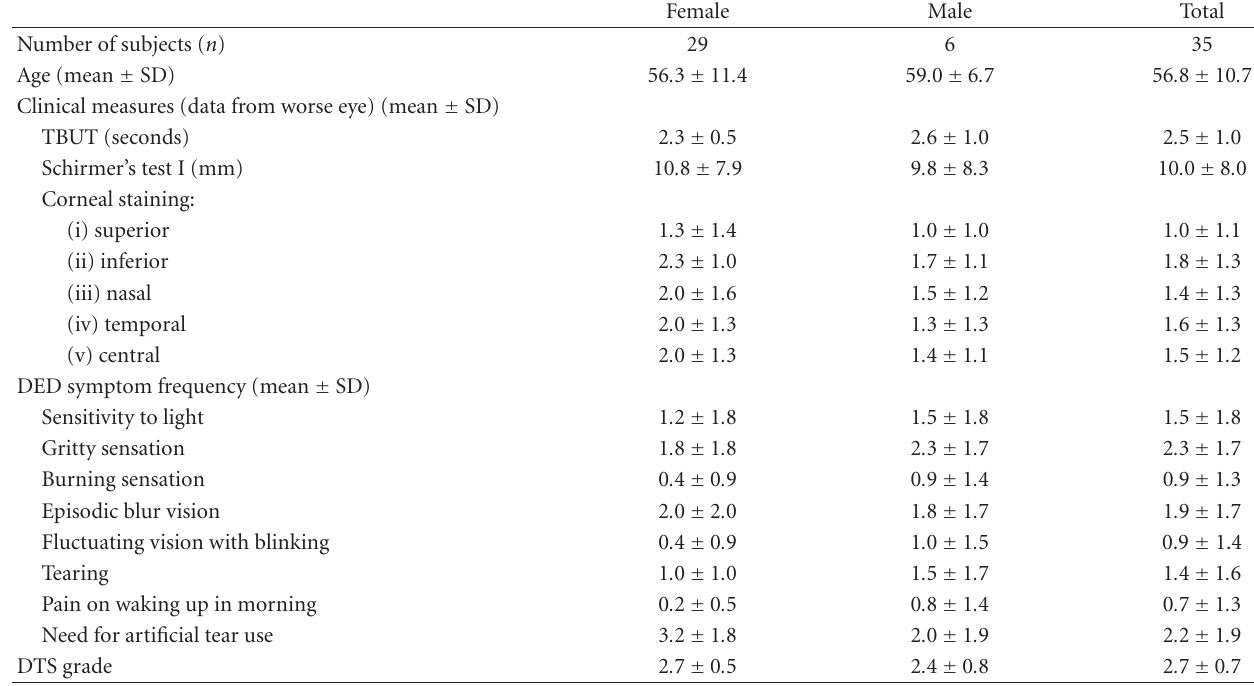
Table 1: Patients’ demographics and mean symptom frequency grade, clinical measure outcomes, and DTS grade. Female